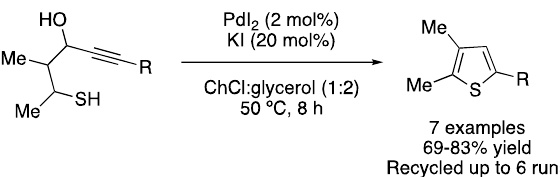
Figure 13 . Synthesis of substituted thiophenes by PdI 2 /KI-catalyzed heterocyclization.